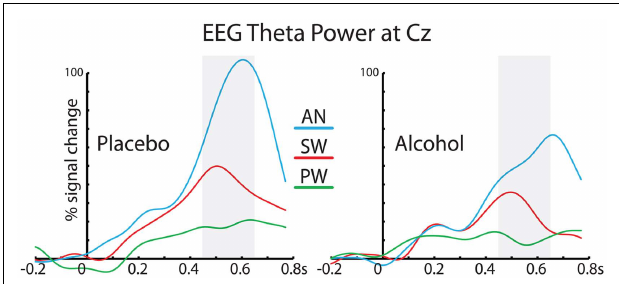
FIGURE 5 | Group average total event-related power in theta frequency band recorded at Cz and expressed as relative change from the baseline. The timecourses for the three stimulus conditions are superimposed and shown for placebo and alcohol.The vertical shaded bars denote the 450–650ms time window used in the statistical